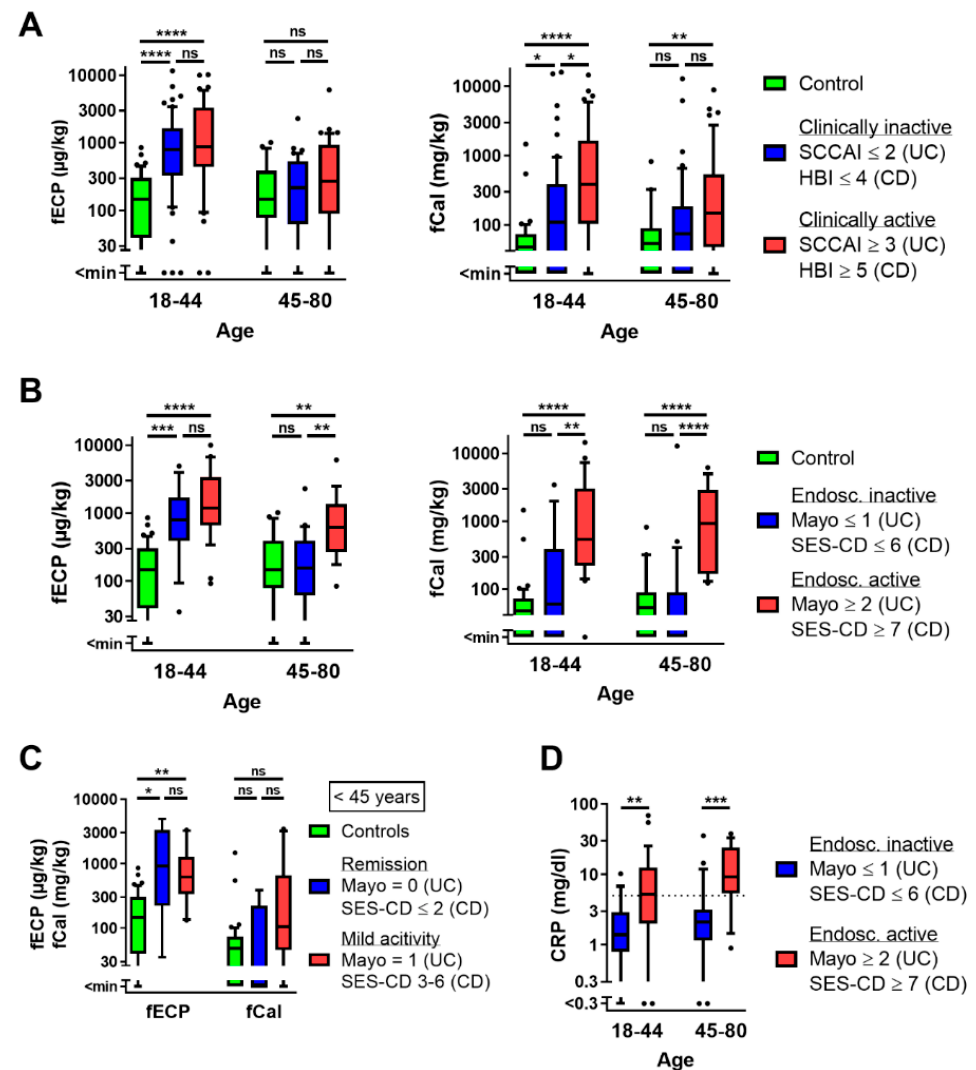
Figure 1. Age dependency of fECP and fCal. ( A ) fECP and fCal in controls ( < 45 years, n = 52; ≥ 45 years, n = 26) and clinically inactive ( < 45 years, n = 60; ≥ 45 years, n = 42) and active ( < 45 years, n = 44; ≥ 45 years, n = 47) patients with IBD according to the clinical scores (SCCAI for UC, HBI for CD). ( B ) fECP and fCal in controls ( < 45 years, n = 52; ≥ 45 years, n = 26) and endoscopically inactive ( < 45 years, n = 15; ≥ 45 years, n = 22) and active ( < 45 years, n = 29; ≥ 45 years, n = 17) patients with IBD according to the endoscopic scores (Mayo for UC, SES-CD for CD). ( C ) fECP and fCal in controls ( n = 52), patients with IBD in complete endoscopic remission ( n = 5) and patients with IBD with mild endoscopic activity ( n = 10) below the age of 45 years. ( D ) Serum CRP levels in endoscopically inactive ( < 45 years, n = 15; ≥ 45 years, n = 22) and active ( < 45 years, n = 28; ≥ 45 years, n = 17) patients with IBD. Kruskal–Wallis test followed by Dunn’s post-hoc comparisons (three groups) or Mann–Whitney U test (two groups); *, p < 0.05; **, p < 0.01; ***, p < 0.001; ****, p <